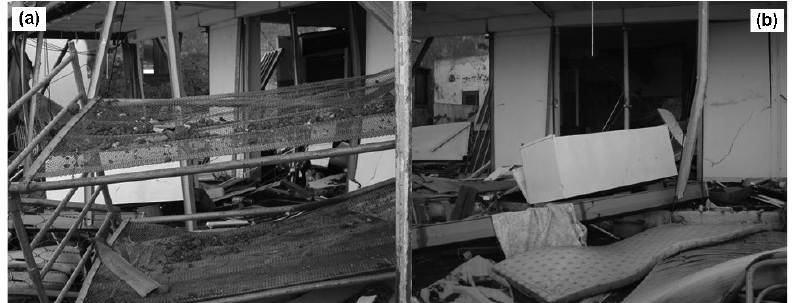
Fig. 12. Two pictures of building #5 (Punta Lena, Stromboli – Fig. 6) taken after the 2002 tsunami. The flow broke doors and windows, penetrated indoors and dragged the building contents outside (a) . A large crack can be observed in the front side wall (b) . However, that wall does not appear to be part of the load-bearing structure of the building, as does the undamaged column at its right. The PTVA-3 Model classified building #5 as having an “average” RVI score.